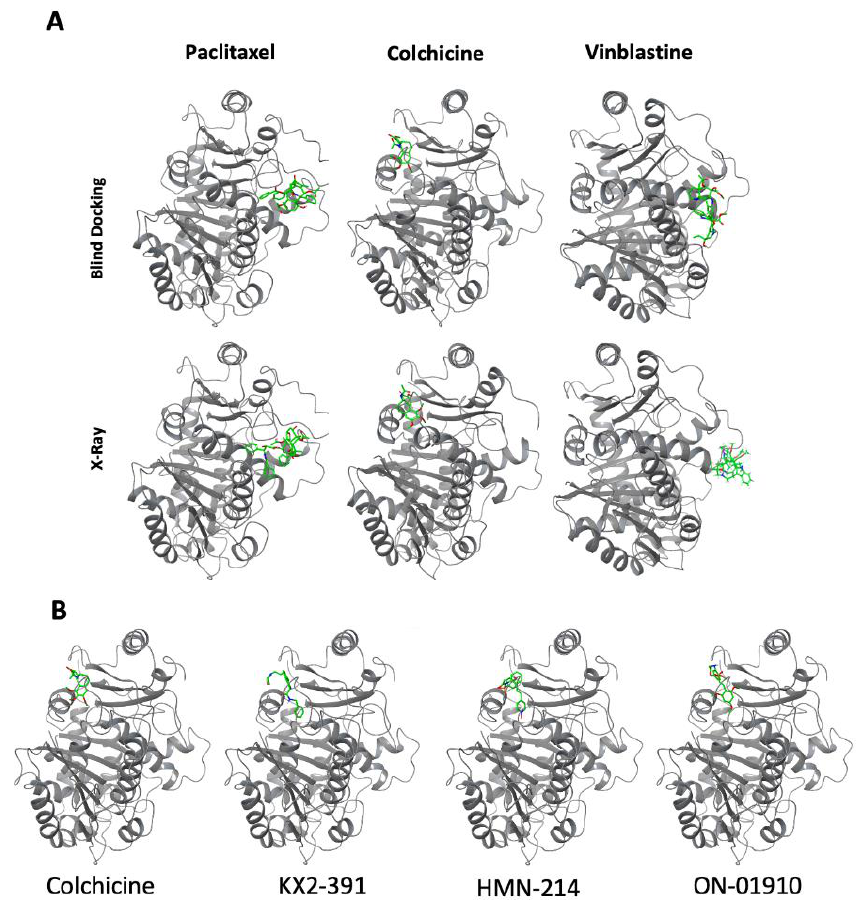
Figure 5. Identification of the molecular binding site in β -tubulin of kinase inhibitors that inhibit tubulin polymerization using blind docking. ( A ) A comparison of molecular blind docking vs. experimental X-Ray structure data of the 3D binding site in β -tubulin of drugs that inhibit tubulin polymerization (colchicine, vinblastine) or a drug that can stabilize microtubules (paclitaxel). Blind docking predictions were made with CB-Dock 2 web server. ( B ) A comparison of the β -tubulin predicted binding site of kinase inhibitors (KX2-391, HMN-214, ON-01910) that can inhibit tubulin polymerization against the binding site of colchicine.